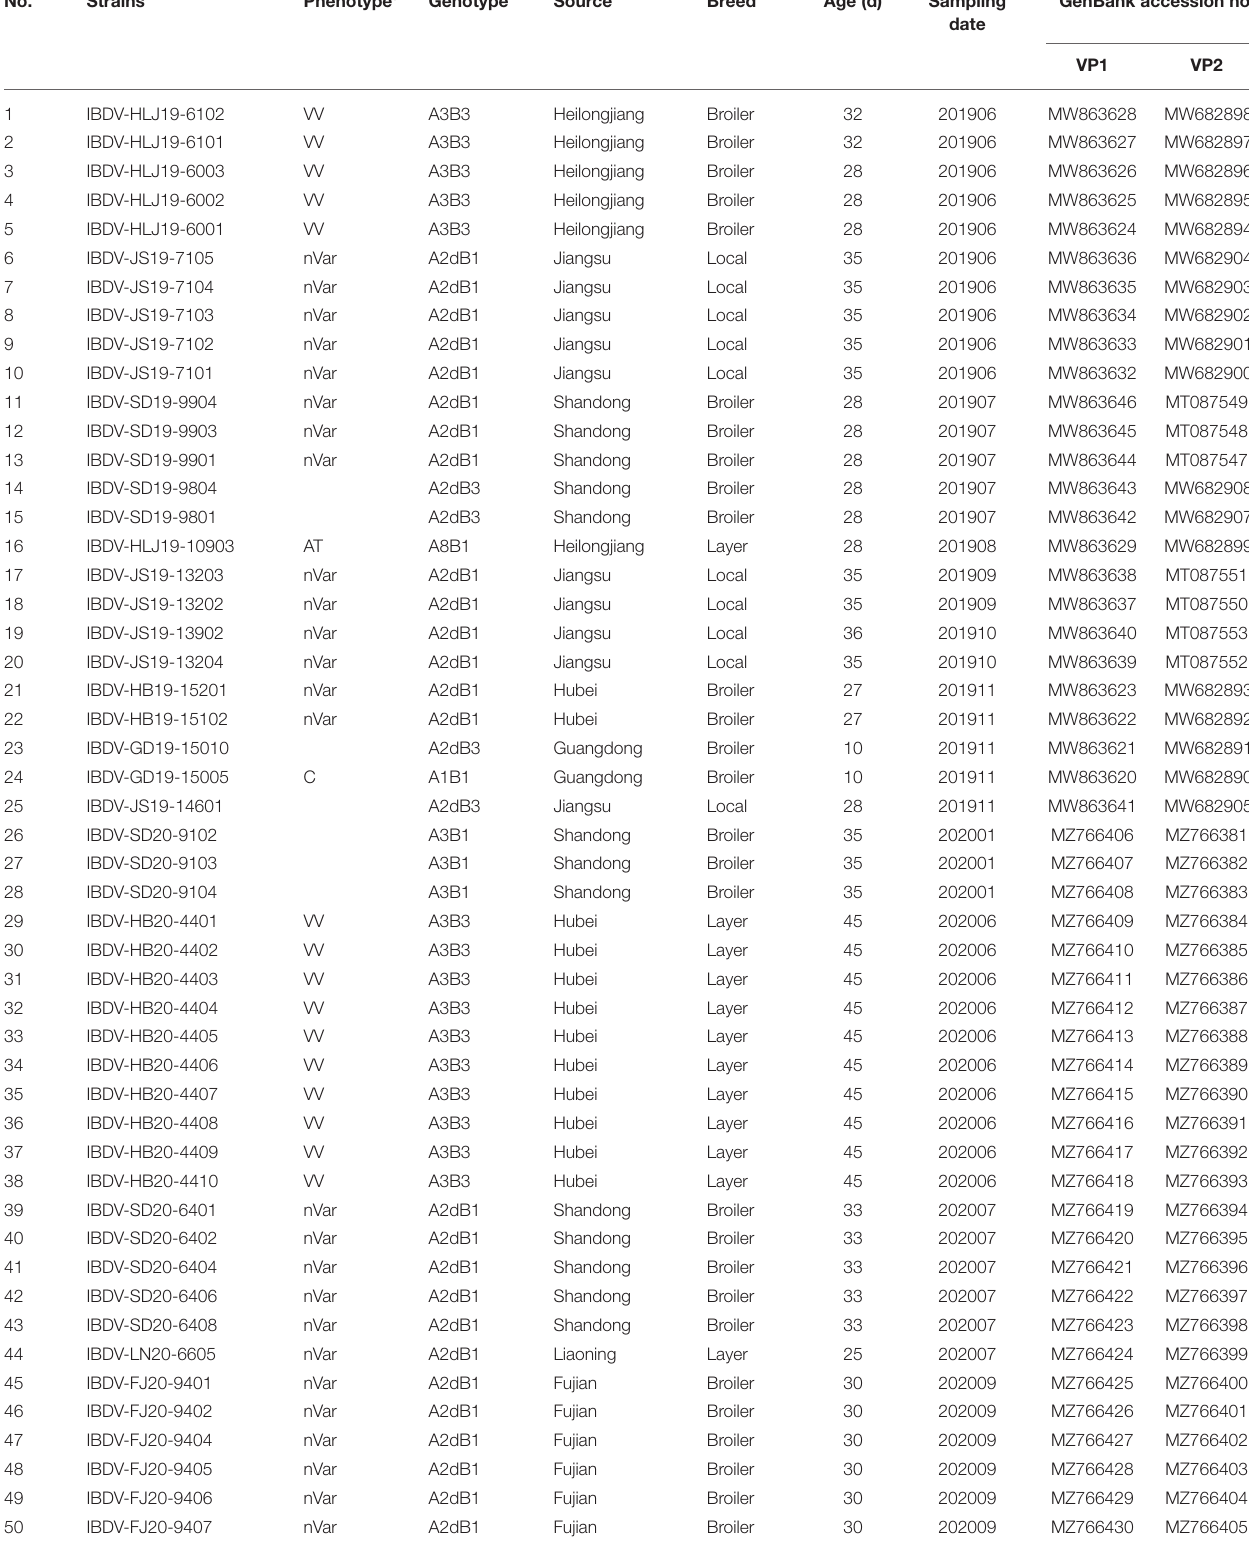
TABLE 1 | The IBDV strains identified in this study.